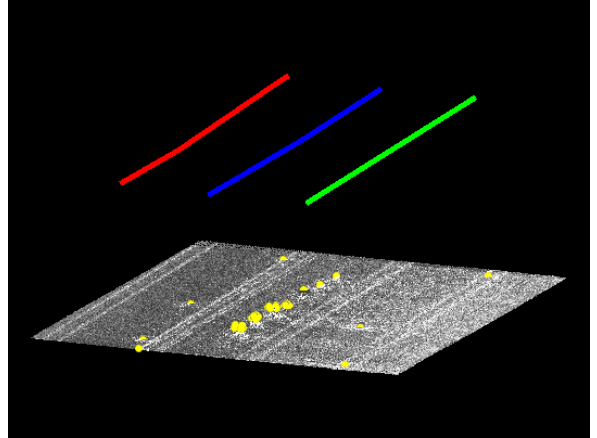
Figure 7 . Point cloud from Flight 1, GNSS and total station survey. Blue: Strip 1; green: Strip 2; red: Strip 3; yellow control stations, total station set-ups and target